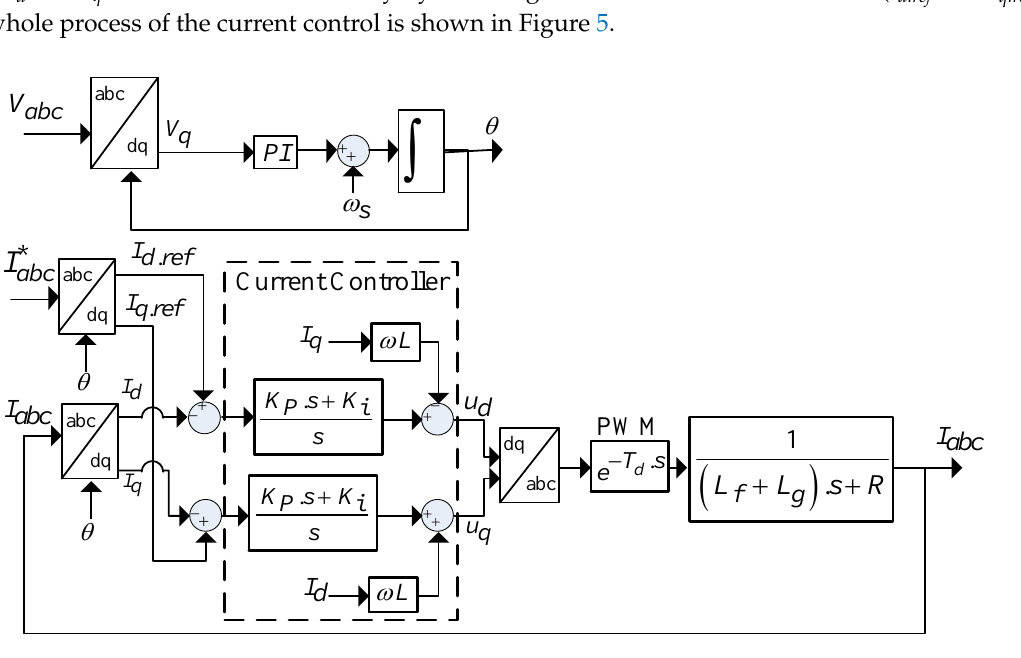
Figure 5. Block diagram of the grid-connected VSC including the current control and the time